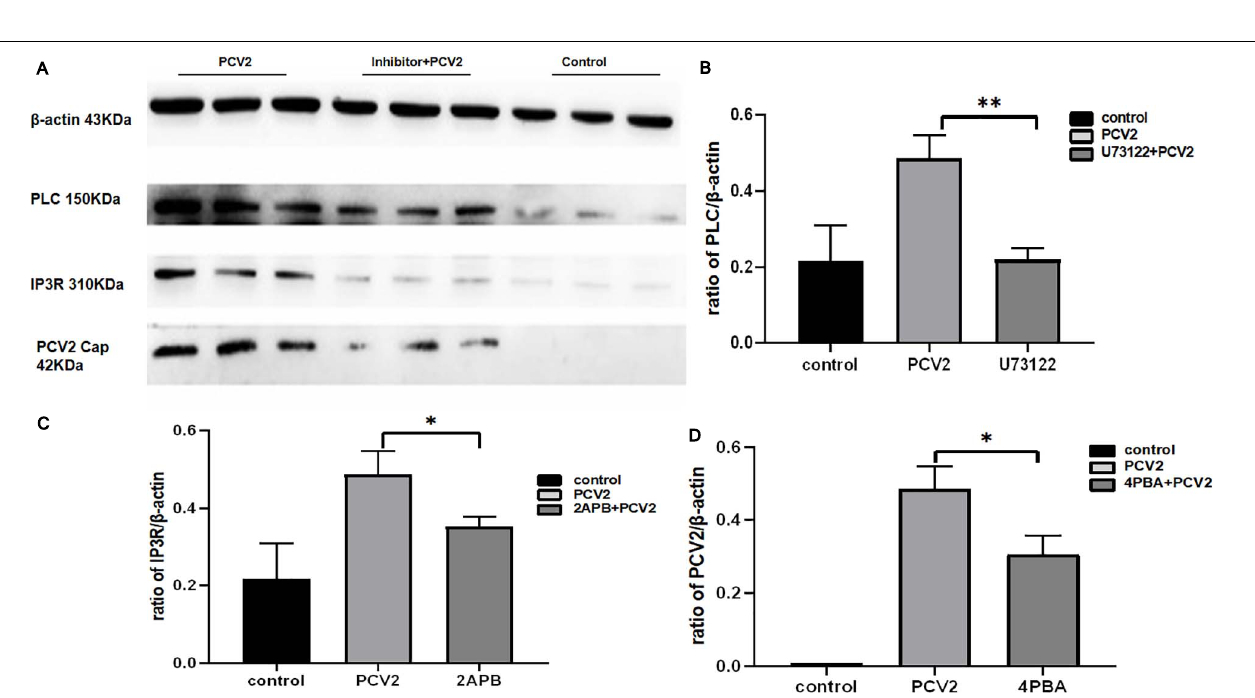
FIGURE 4 | PLC colocalizes with IP3R in PCV2 infect PK-15 cells. Laser confocal immunofluorescence was used to detect the expressions of PLC and IP3R in PK-15 cells infected with PCV2. The red is IP3R protein, the green is PLC protein, and the yellow part is the colocation of the two proteins. (A–C) are the expression and colocalization of protein in cells after virus infection. (D–F) are the colocalization of the protein in the control group of PK-15 cells without PCV2 infection.